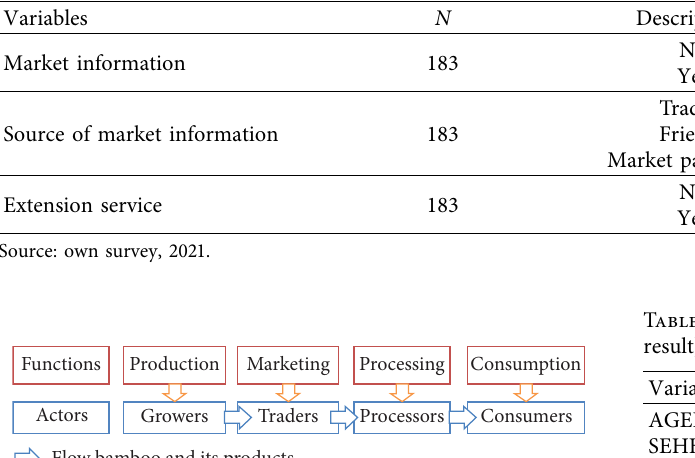
Table 4: Households access for market information and extension service.